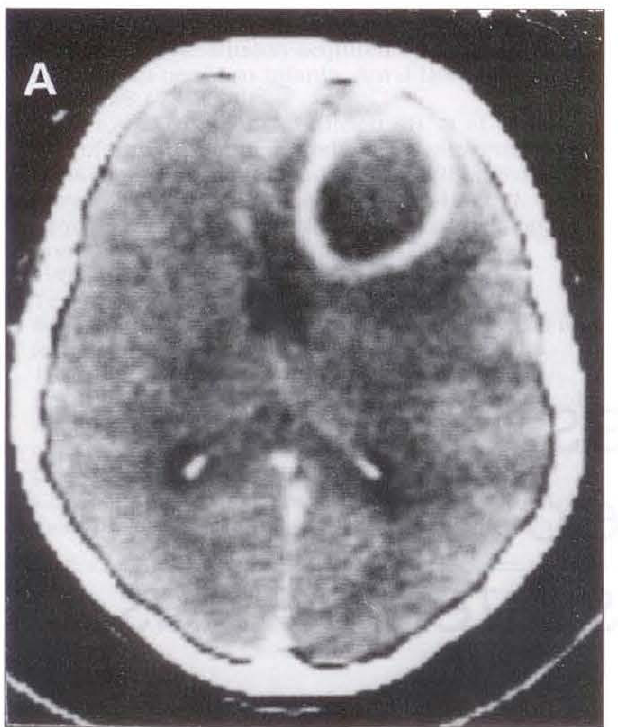
Figure 1) Computed axial tomographic scan of brain abscess done on the .first hospital day. Note the large contrast-enhancing ring lesion in the leflfrontal lobe. Also note compression of the left lateral ventricle and shift of the midline stntclures to the right